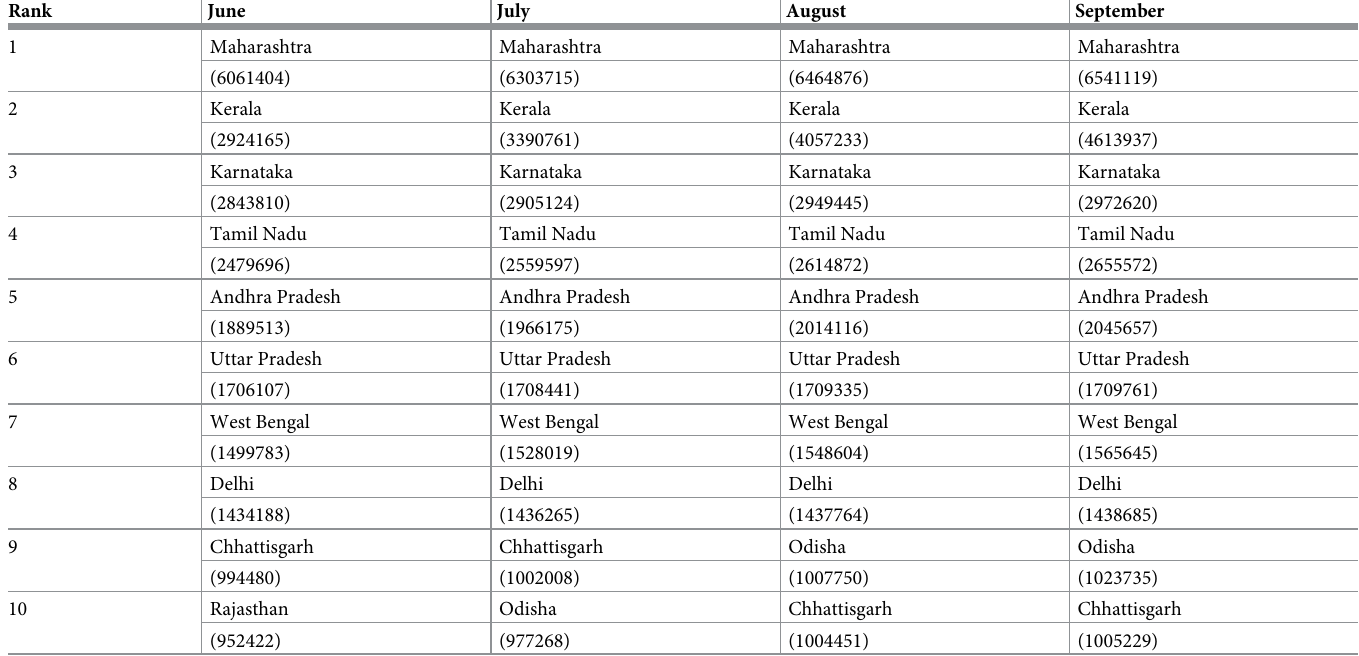
Table 4. Rank of states by number of novel total cases taken at the 1st of every month for June to September 2021 [15]. The number of novel cases are shown in brackets.